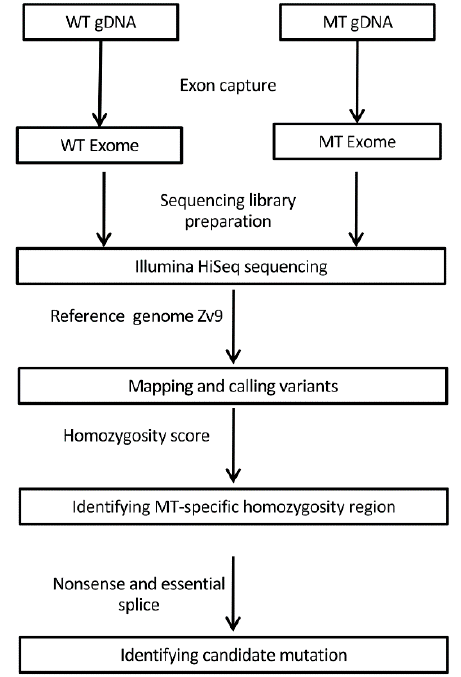
Figure 1. Schematic of whole-exome sequencing (WES) workflow and analysis. Exons were captured from wildtype (WT) and cp27.5 mutant (MT) genomic DNA (gDNA) and analyzed to identify the candidate mutation.